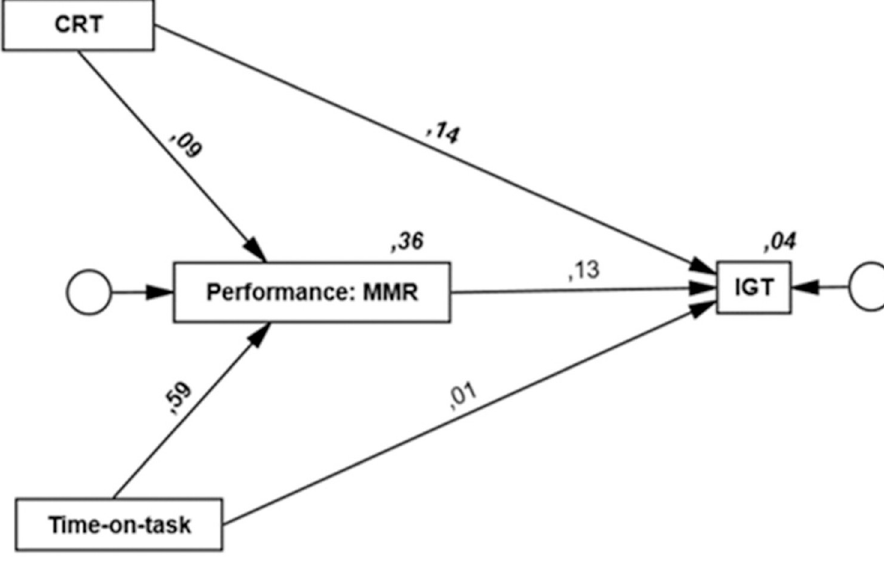
Fig 2. Path model with Iowa Gambling Task (IGT) regressed on match-making rating (MMR), cognitive reflection task (CRT), and Time-on-task. Digits on bold represent significant standardized regression weights. Digits in italics show squared multiple